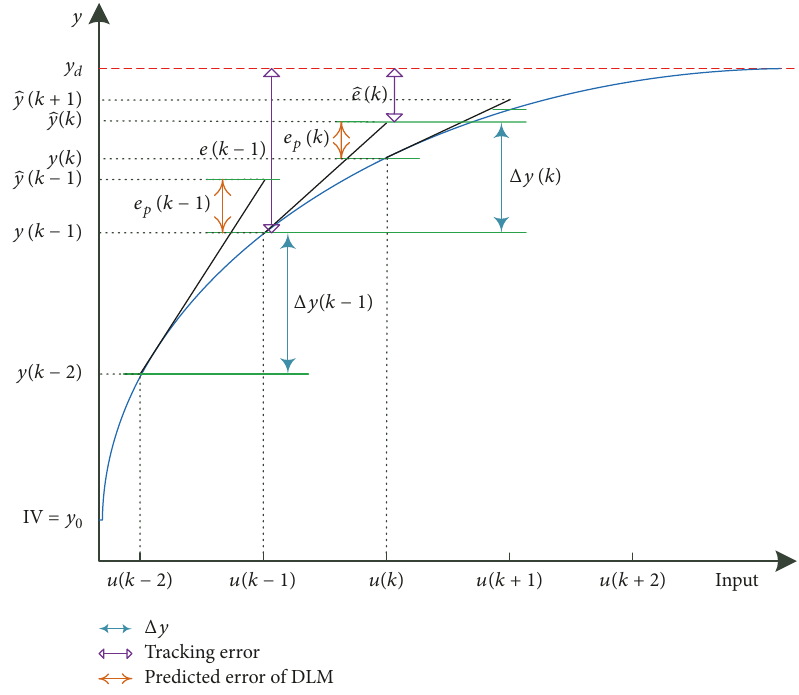
Figure 2: The variable relations during control process of MFAC and